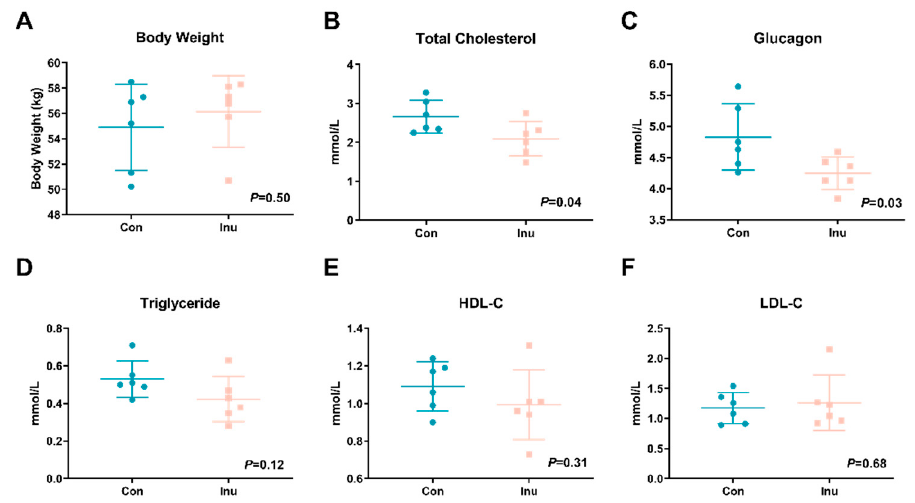
Figure 1. Body weight ( A ), fasting serum total cholesterol ( B ), glucose ( C ), triglyceride ( D ), high-density lipoprotein cholesterol (HDL-C) ( E ) and low-density lipoprotein cholesterol (LDL-C) ( F ) in growing pigs fed a diet with or without a 5% inulin supplement. All data are expressed as mean ± SD ( n = 6).